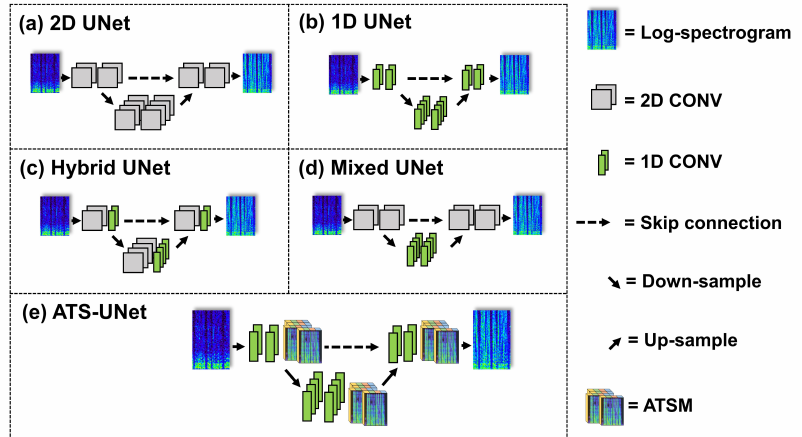
Figure 3. Our proposed series of novel network architectures including a variant 2D-UNet, 1D-UNet, Hybrid-UNet, Mixed-UNet, and